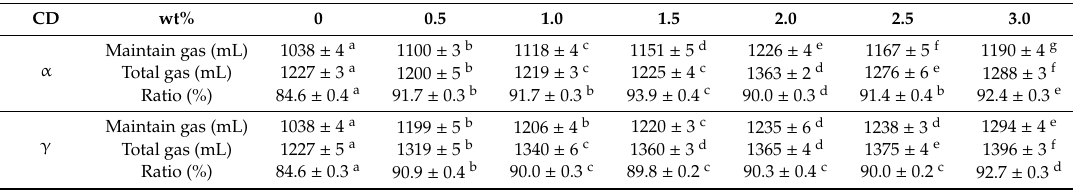
Figure 1. Effect of the addition of 0–3.0 wt% α -CD ( A ) and 0–3.0 wt% γ -CD ( B ) on dough fermentation height as observed with the F4 fermentation rheometer. Dough was fermented at 28 °C for 135 min. Table 2. E ff ects of di ff erent concentrations of α -CD and γ -CD (0–3.0 wt%) on the dough volume, total gas, and maintain gas volume (135